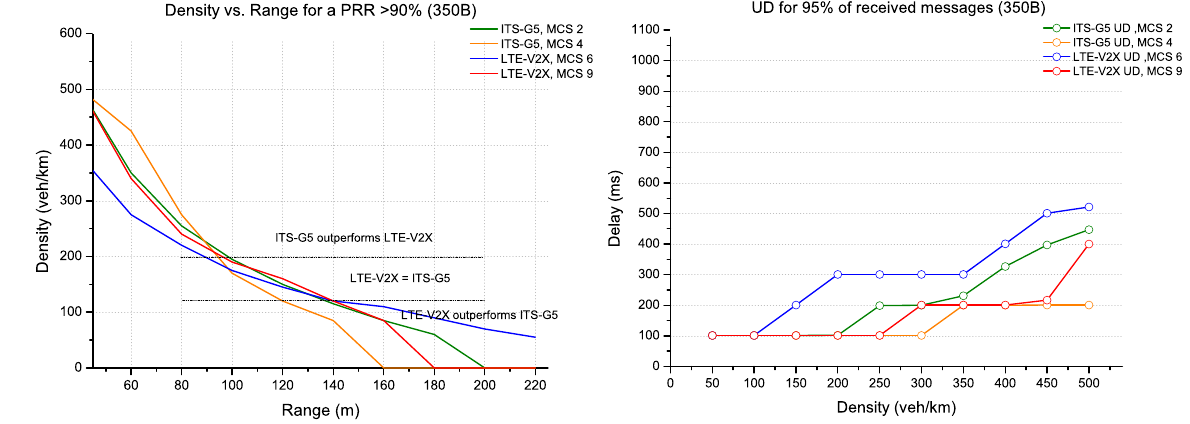
Figure 11. ITS-G5 vs. LTE-V2X comparison for packet size 350